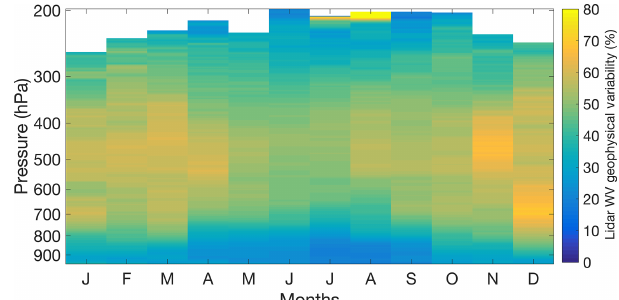
Figure 4. The water vapour mixing ratio systematic uncertainty budget for each night used in the water vapour climatology (dashed grey lines) and the average uncertainty contribution from each component (dashed black line). The largest contributors are the Ångstrom exponent and the calibration constant. A total of 4 nights out of 1300 had Ångstrom exponent uncertainties larger than 5% due to our assumed value not fitting with persistent clouds. The av- erage uncertainty contribution from the NCEP air density is 0.25%. All other uncertainties contribute less than 0.1% on average.